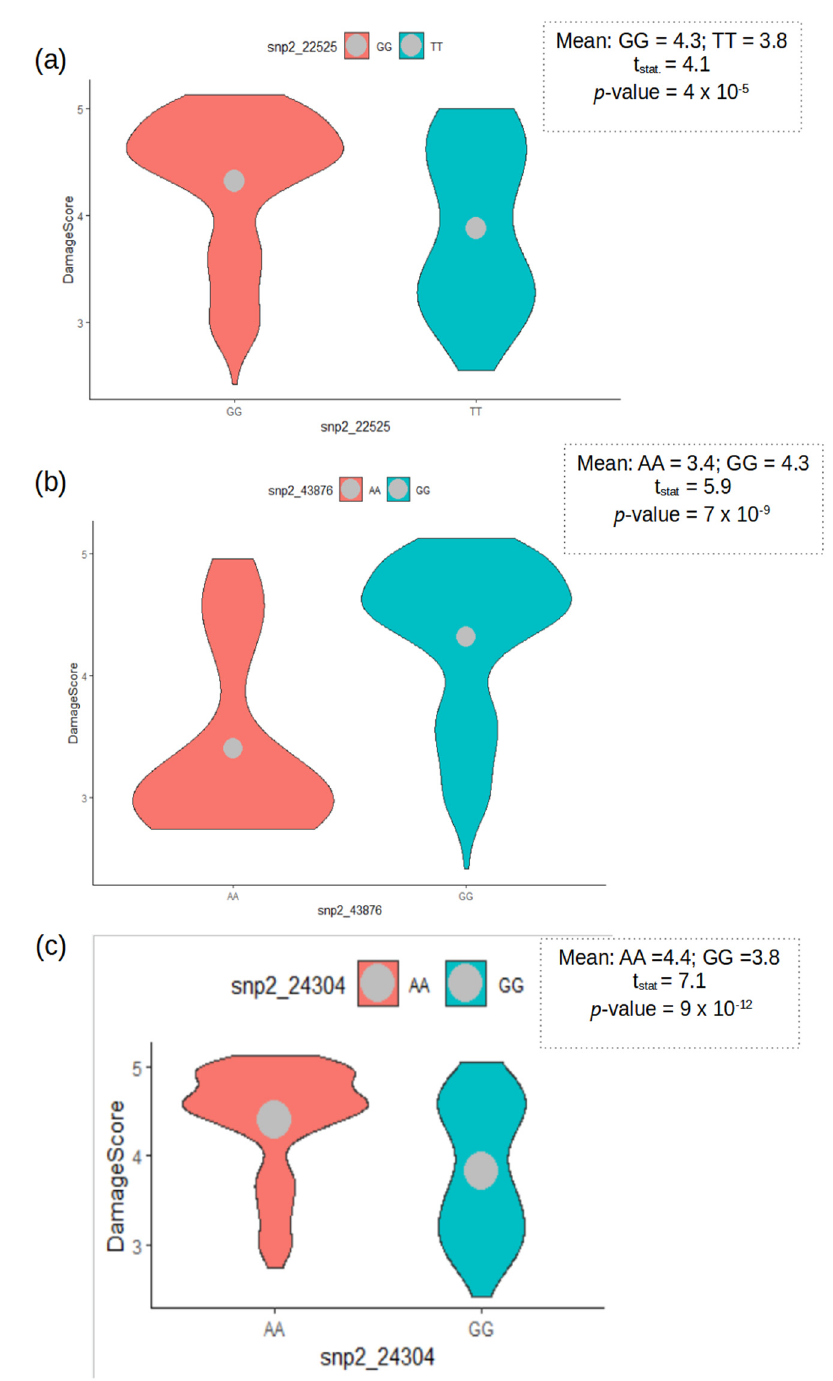
Figure 5. Single-marker differentiation of accessions by the two alleles of each peak SNP at the three major association signal regions on: ( a ) chromosome Vu08 represented by SNP marker 2_22525; ( b ) chromosome Vu10 represented by SNP marker 2_43876; ( c ) chromosome Vu02 represented by SNP marker 2_24304. Boxplots depict extent of dispersion within allelic categories of peak SNPs. Square dash-line box inserts show the results of t -tests for differences between the means of two groups categorized based on SNP marker